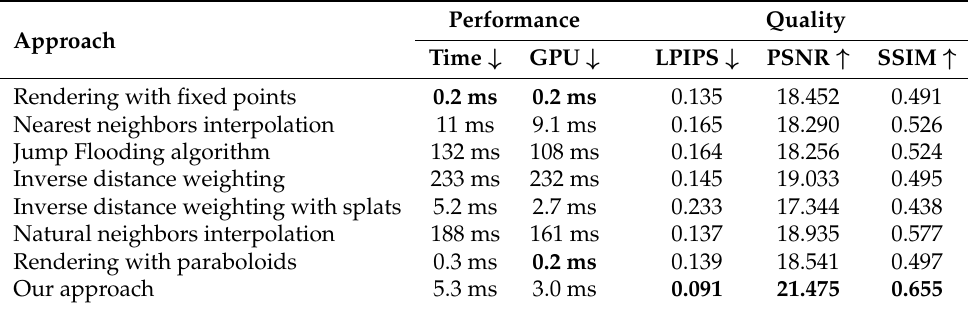
Table 1. Results of all implemented algorithms with values averaged across all test cases. In bold are the values of best values according to the used metric.